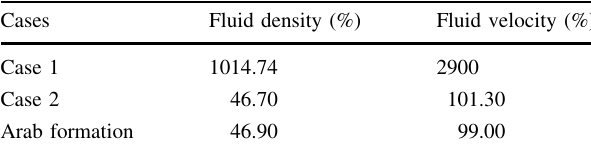
Table 9 Change in percent in fluid density and fluid velocity